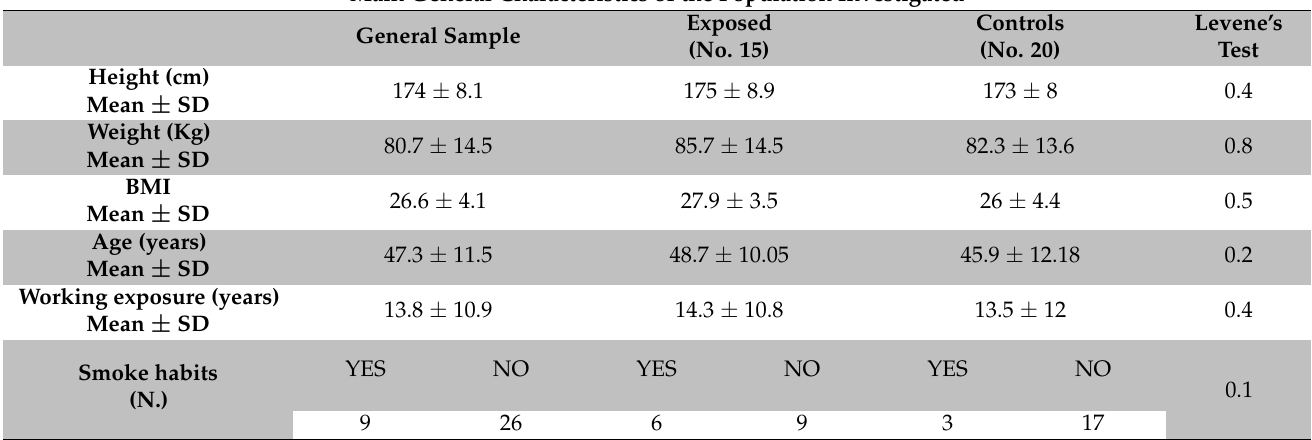
Table 3. General descriptive of the population under study. No differences between groups were detectable (Levene’s test of homogeneity of variance). Values are mean ± SD. Main General Characteristics of the Population Investigated